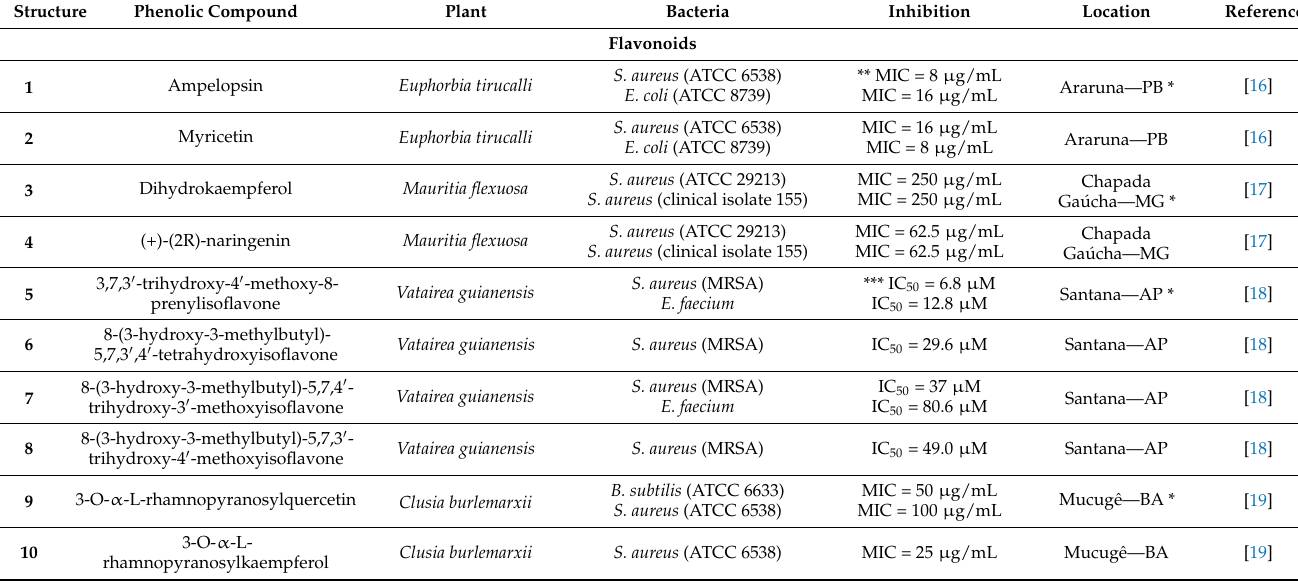
Table 1. Phenolic Compounds isolated from plants in Brazil and their respective antibacterial activities.